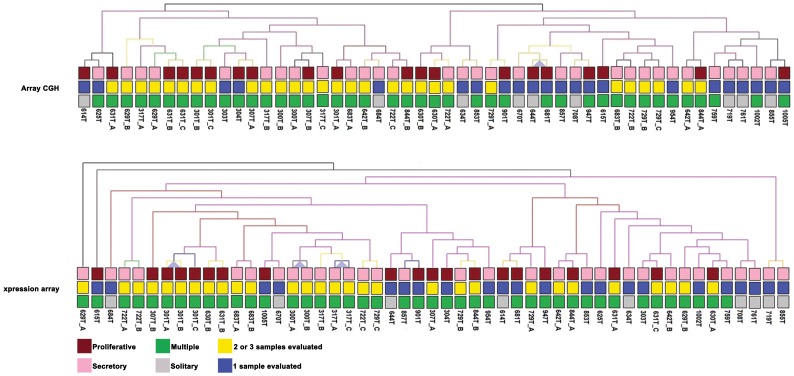
Hierarchical clustering.The patients were grouped according to the menstrual cycle phase (proliferative and secretory), number of samples evaluated and diagnosis of multiple or solitary tumours. These results show that the genomic and transcriptomic data were useful to clustering the samples regardless of the clinical features, indicating that could be markers to tumour biology (TMeV v.4.5).